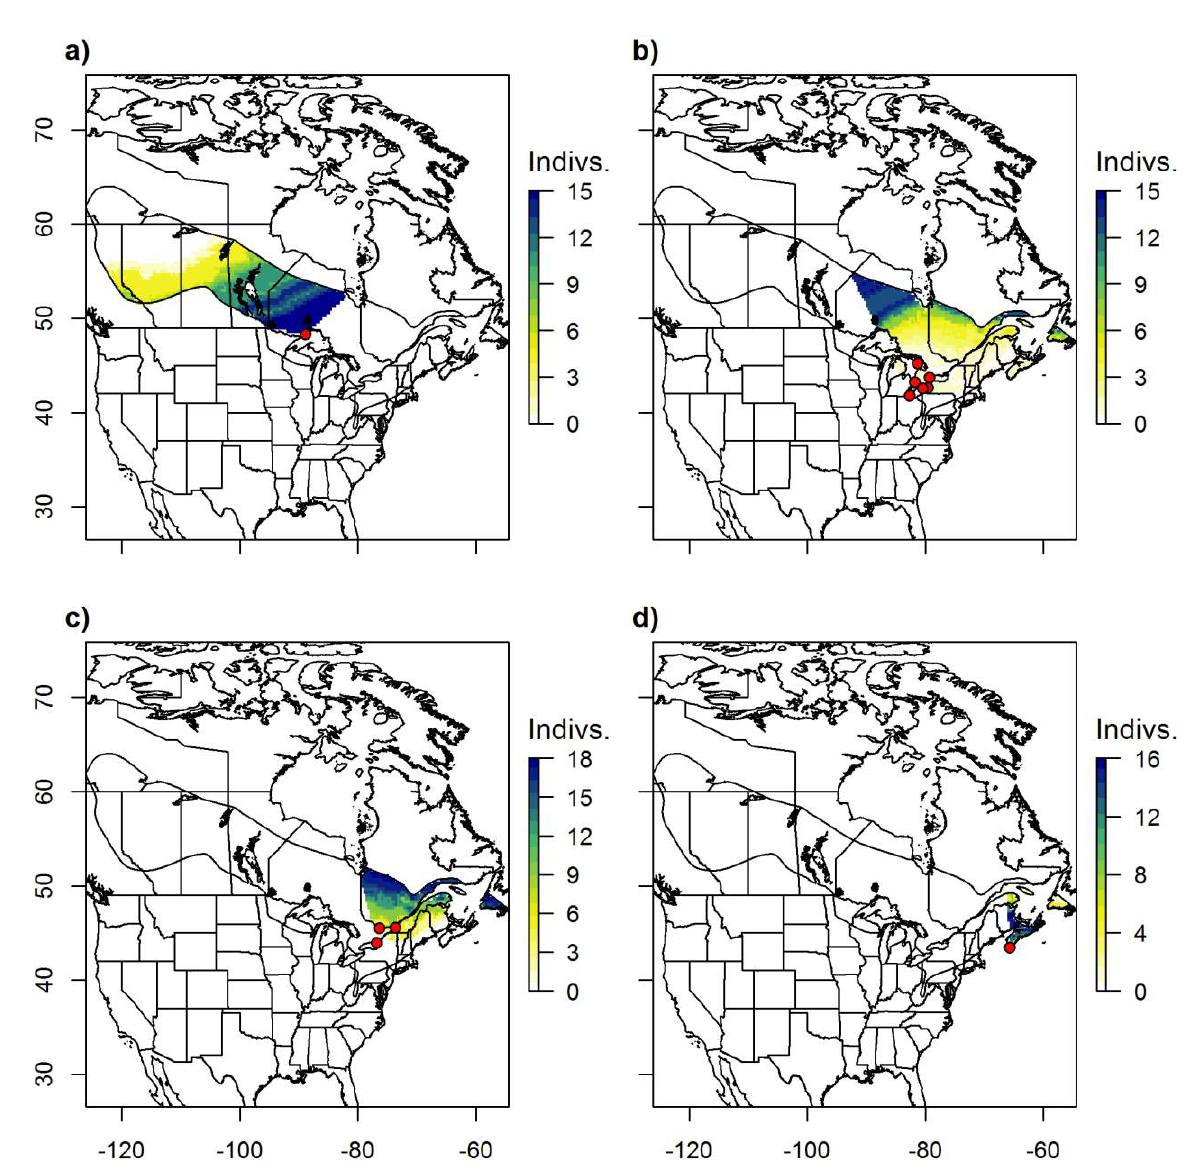
Figure A2.14: Probable origins of Magnolia Warblers ( Setophaga magnolia ) captured during spring migration at CMMN stations in a) Western Ontario (TCBO (n=20)); b) Southwest Ontario (AuBO (n=1), BPBO (n=3), HBO (n=1), LPBO (n=5), PIBO (n=3), TTPBRS (n=5)); c) Southeast Ontario & Southwest Québec (IPBO (n=2), MBO (n=2), PEPTBO (n=16)); and d) Eastern Canada (ABO